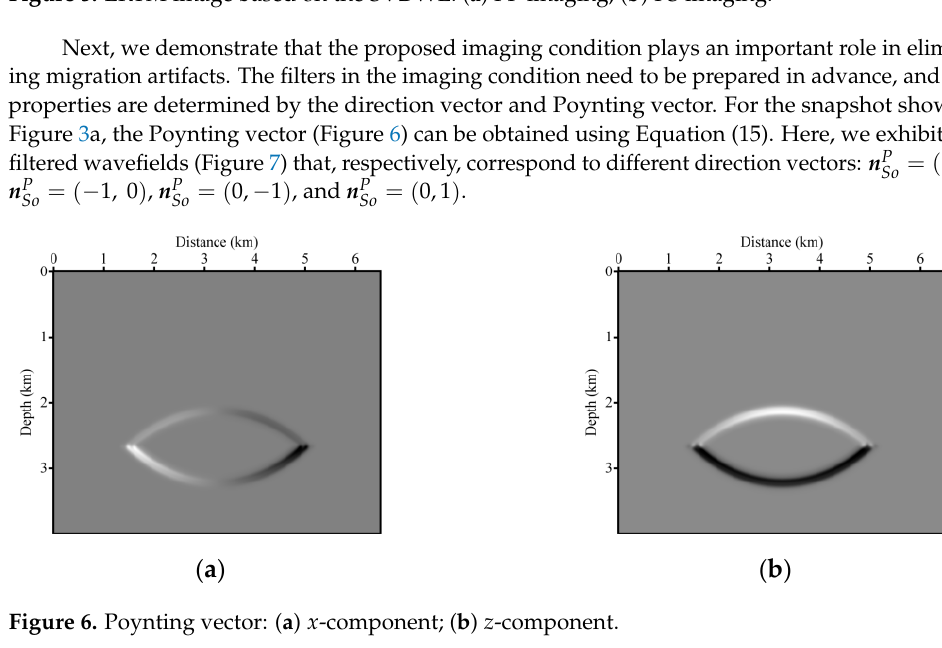
Figure 5. ERTM image based on the SVDWE: ( a ) PP imaging; ( b ) PS imaging.